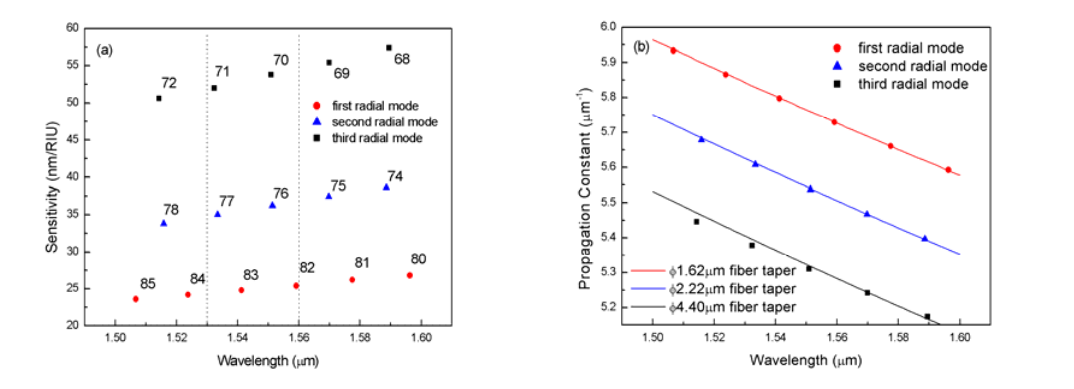
Figure 3. Intensity distribution of the two TM WGMs ( m =85, l =1, top) and ( m =68, l =3, bottom), parameters r